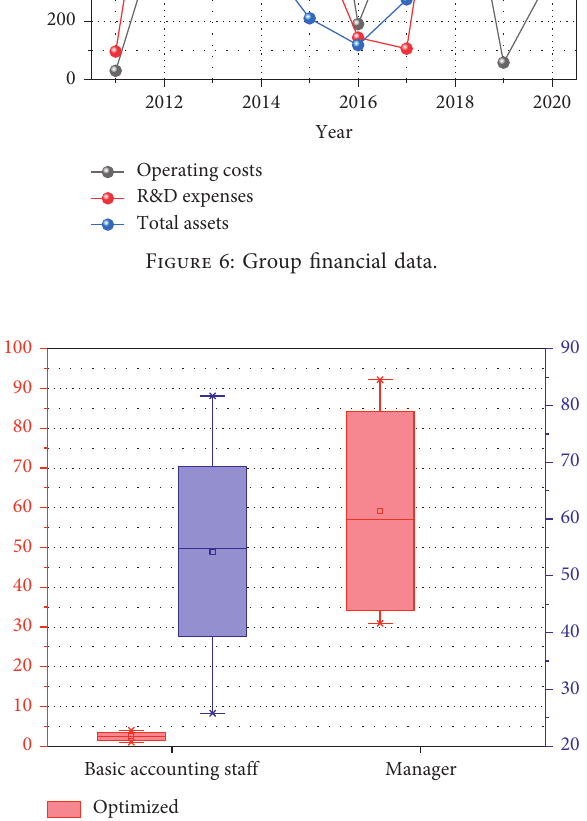
Figure 7: Comparison of organizational functions before and after